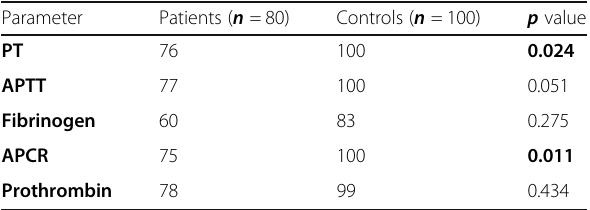
Table 4 Number of participants with normal values of coagulation tests